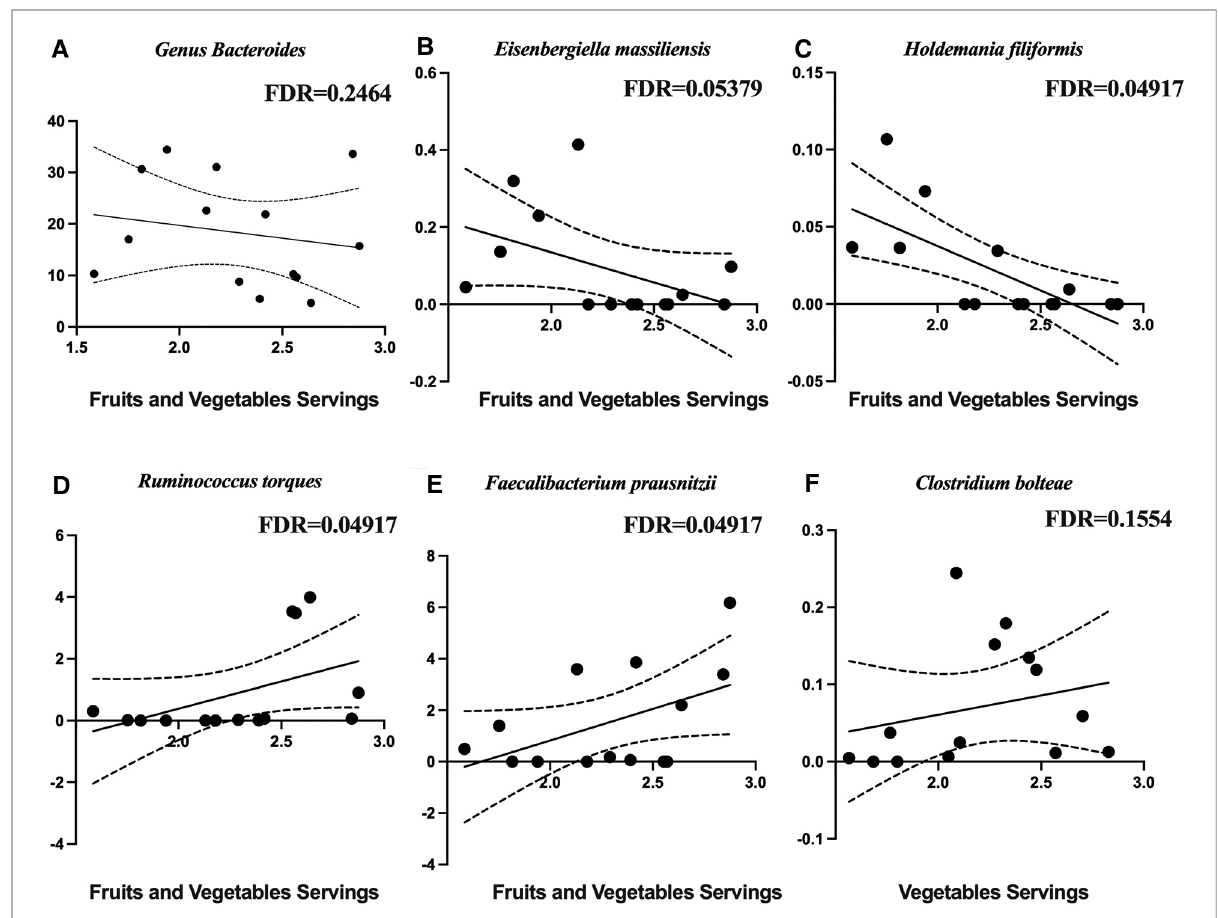
FIGURE 5 Microbial taxa associated with diet in the stroke participants. Negative associations with fruits and vegetables are with ( A ) the genus Bacteroides , ( B ) Eisenbergiella massiliensis , and ( C ) Holdemania fi liformis . Positive associations with fruits and vegetables are with ( D ) Ruminococcus torques , ( E ) Faecalibacterium prausnitzii , and ( F ) clostridium bolteae